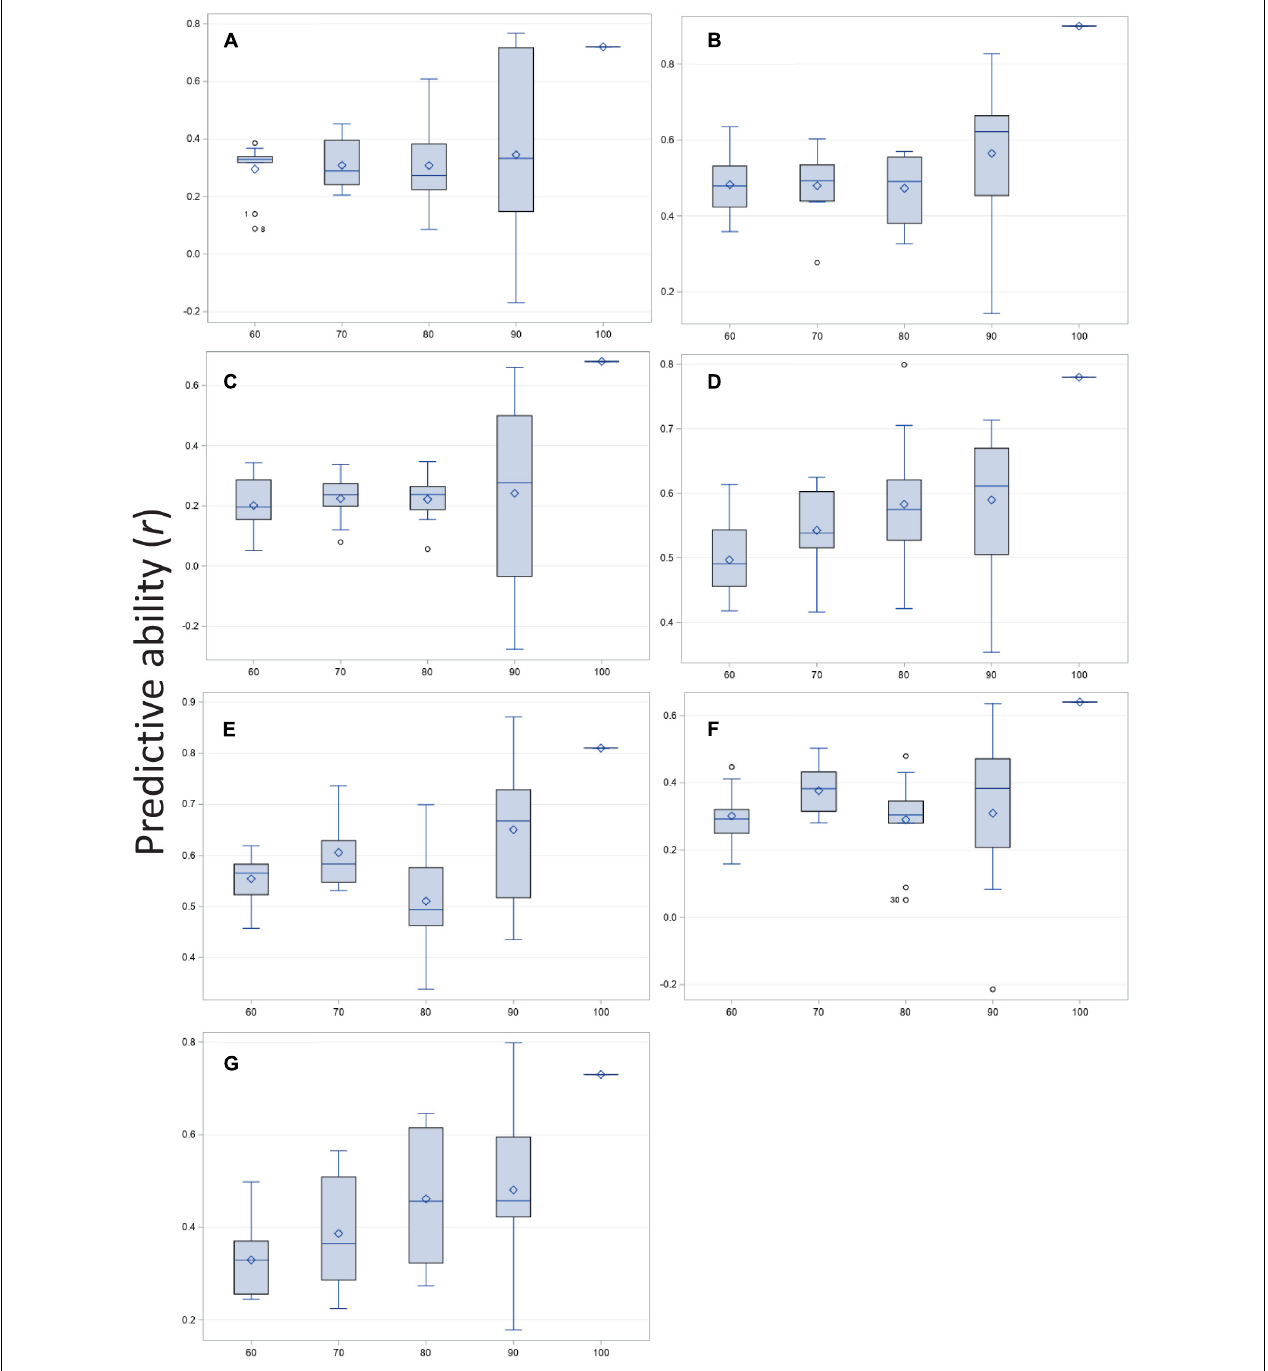
FIGURE 3 | Correlation of predicted and observed values for training vs. testing populations at four ratios (60:40, 70:30, 80:20, and 90:10%) and compared with observed vs. predicted for the entire population (100%) of the BeanCAP Snap Bean Diversity Panel for Fusarium solani root rot disease severity and plant and root traits. Correlation coefficients were generated by rrBLUP using 10 K iterations and 10 repetitions per trait-level combination. (A) Adventitious roots, (B) Biomass, (C) Basal stem diameter, (D) Disease severity, (E) Deep root angle, (F) Shallow root angle, and (G) Taproot diameter.